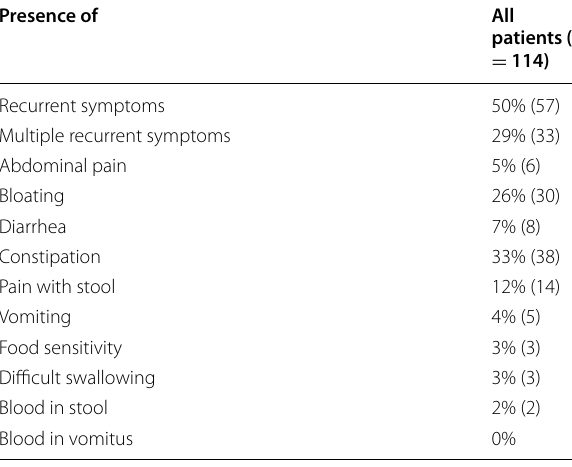
Data are expressed as percentage (number)